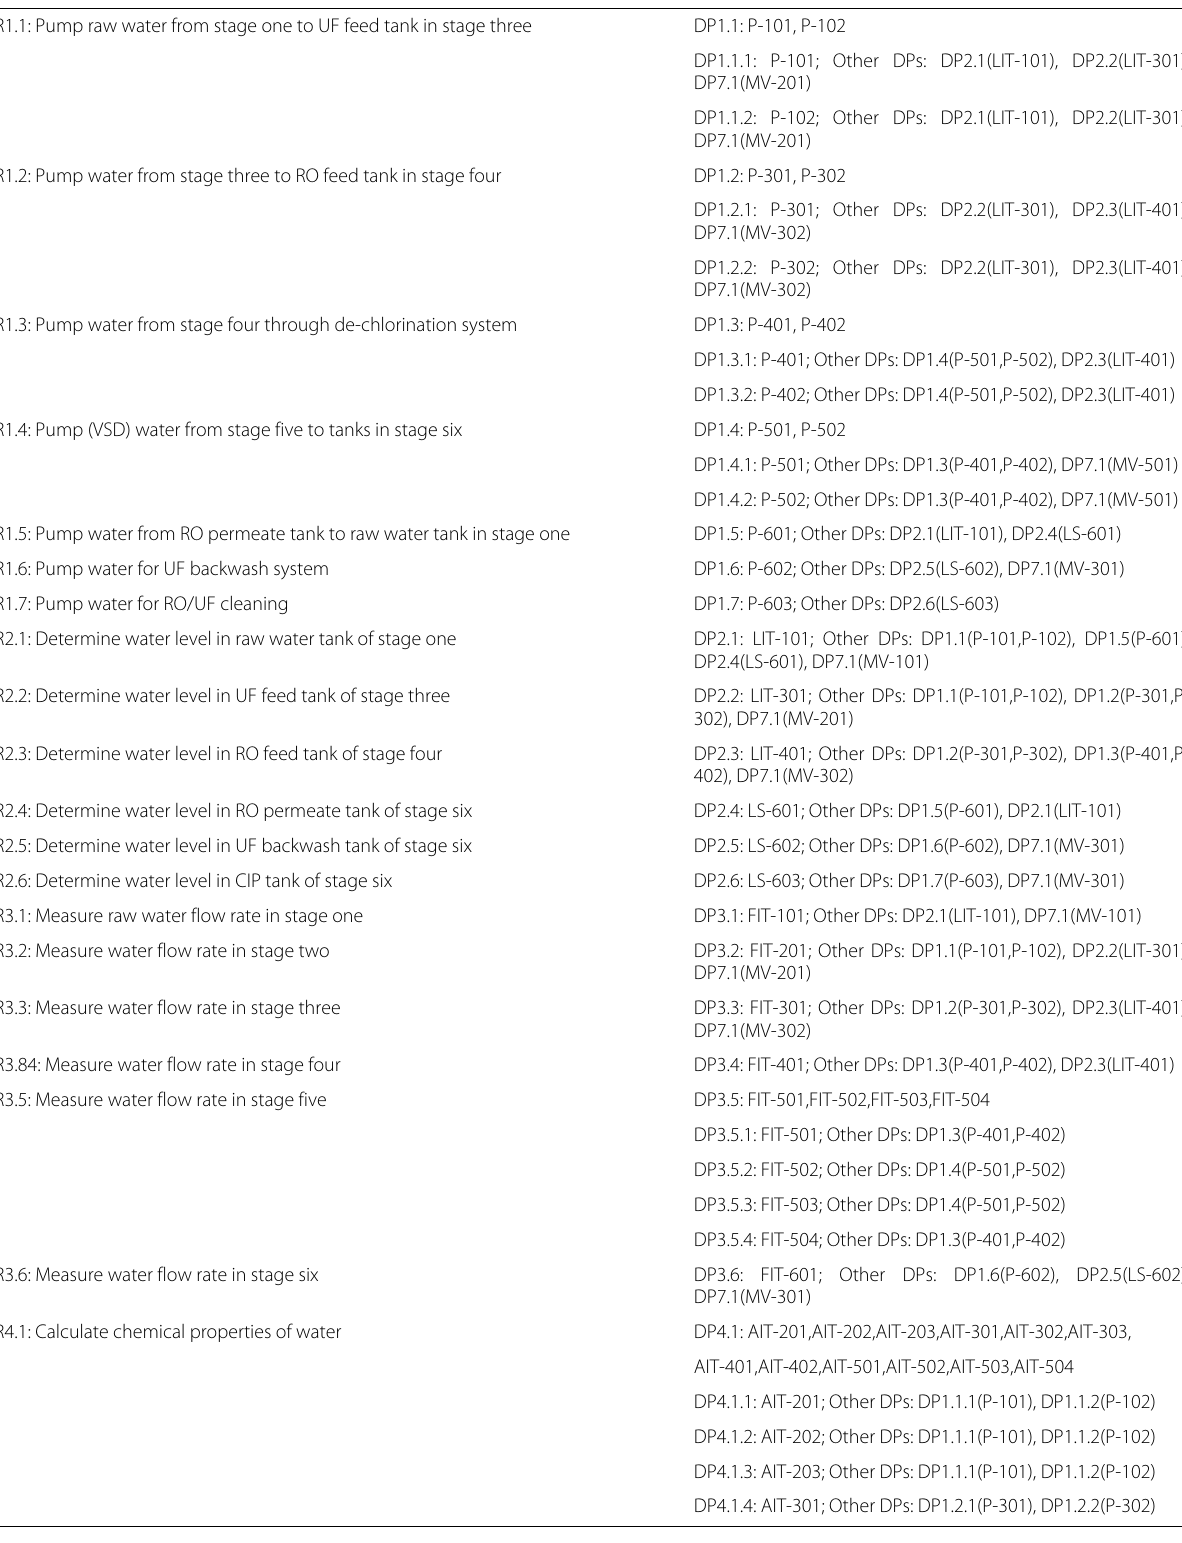
Table 4 Linking SWaT’s second-level decomposition of FRs to dependent DPs Functional Requirements